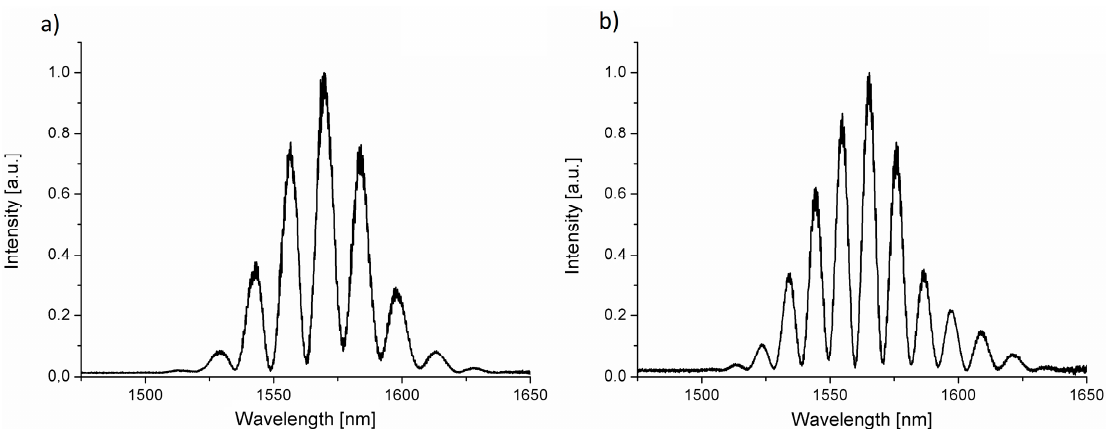
Figure 6. Representative spectra obtained for different hemoglobin concentrations at wavelength 1550 nm on NDD film ( a ) Hb level 7 g/dL; ( b ) Hb level 12.9 g/dL.